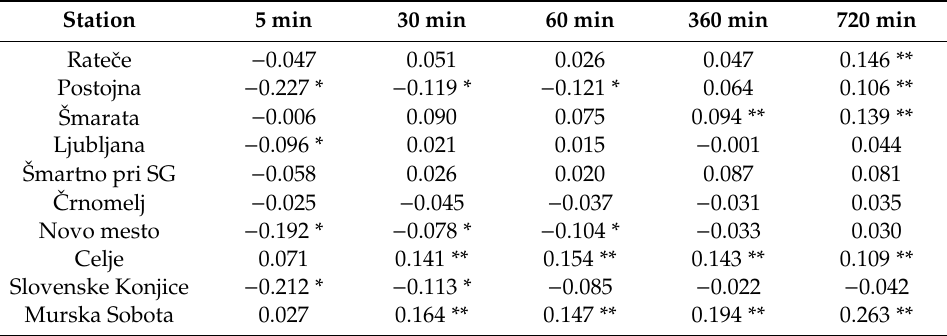
Table 3. Mann-Kendall test results for the AM5 sample. * and ** indicate statistically significant test result (with the 0.05 significance level) that is negative and positive,